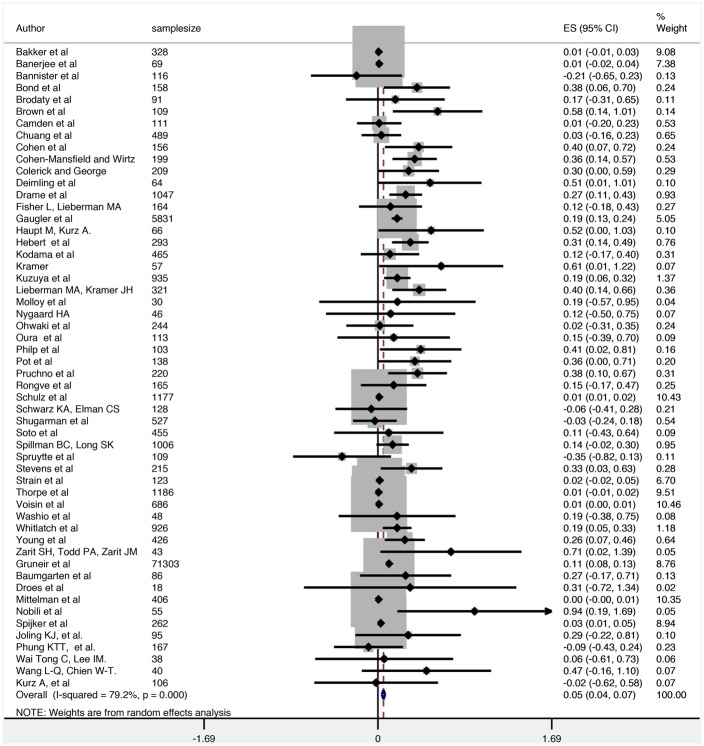
Overall Forest Plot.